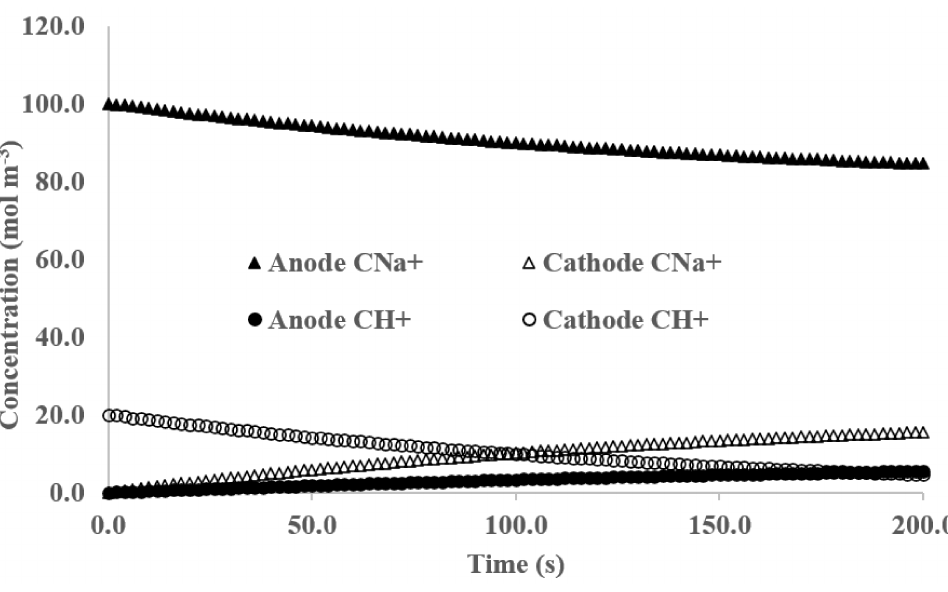
Figure 4. Cation variations in both